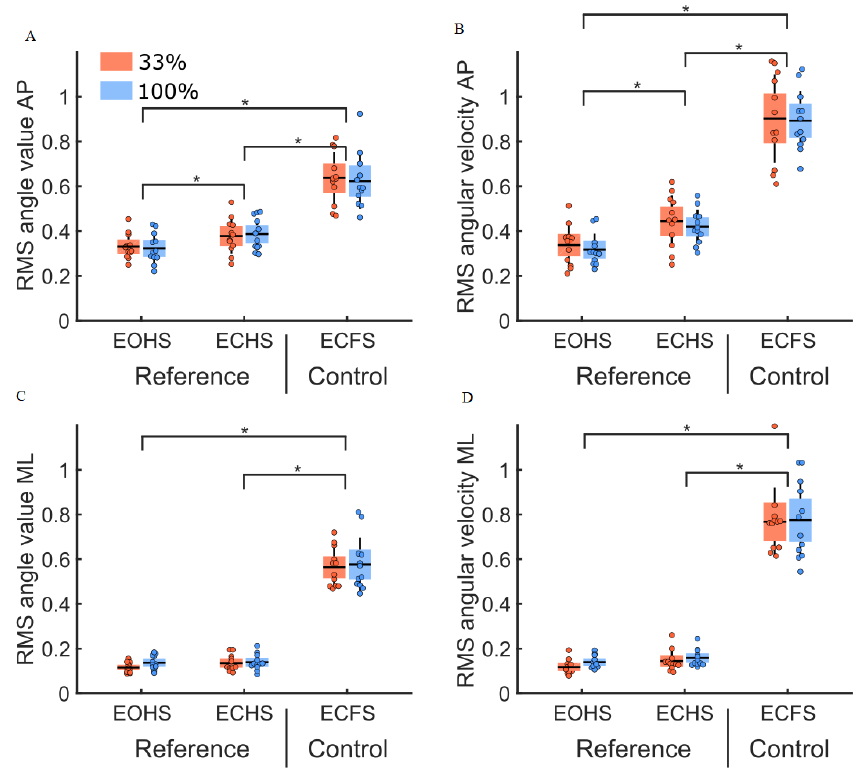
Figure 5. RMS values for body sway angle and angular velocity for both groups (33% and 100% feedback groups, red and blue boxes, respectively) for the reference condition (EOHS and ECHS) and for the control condition (ECFS). Panel ( A , C ) depict RMS values of the body sway angle along the AP and ML axes. Panel ( B , D ) depict RMS values of the body sway angular velocity along the AP and ML axes. The dots represent the mean results for each participant, horizontal lines depict the group’s means, boxes represent the group’s standard error of the mean, and vertical lines, one standard deviation. The units for the RMS values of the body sway angle and angular velocity are (°) and (°/s). The asterisks (*) indicate significant differences between conditions.